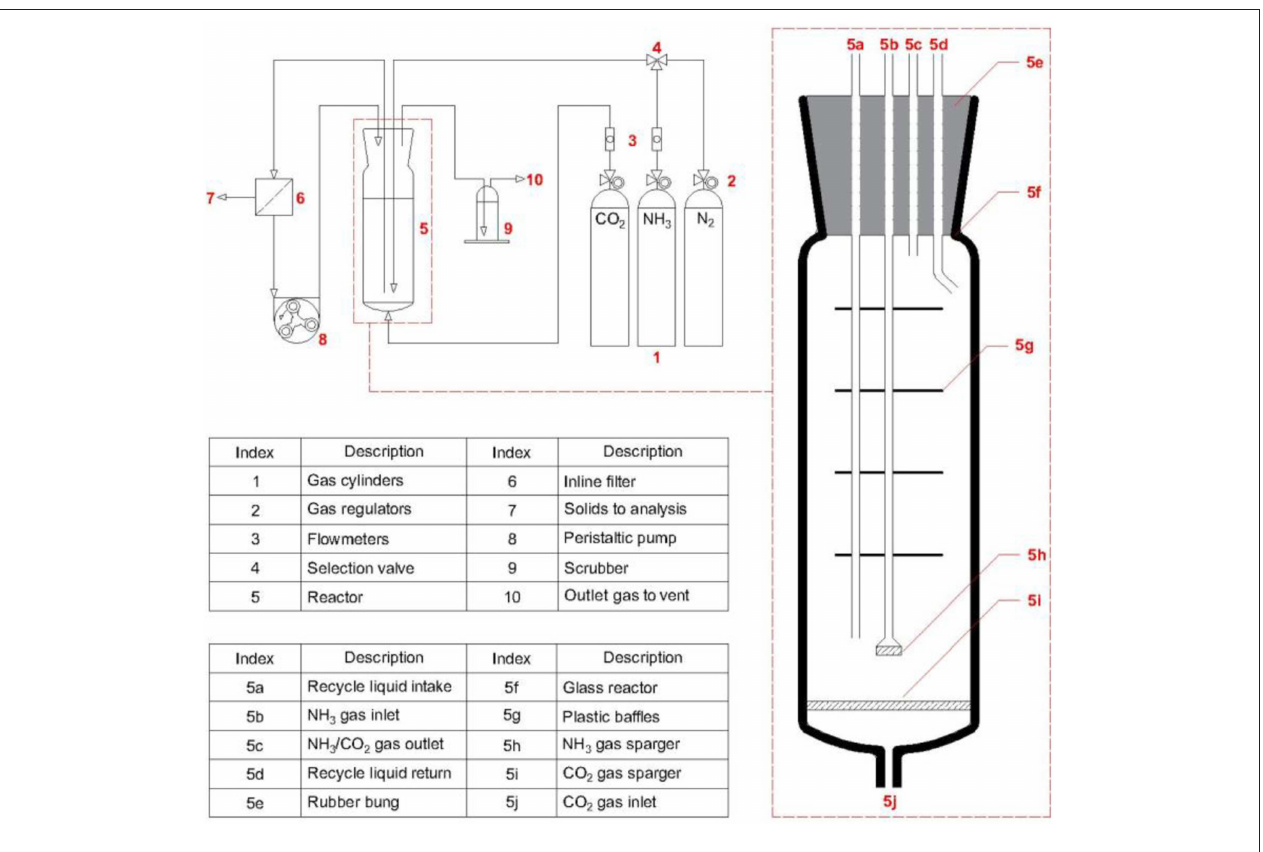
FIGURE 2 | Experimental configuration used throughout synthesis of ammonium